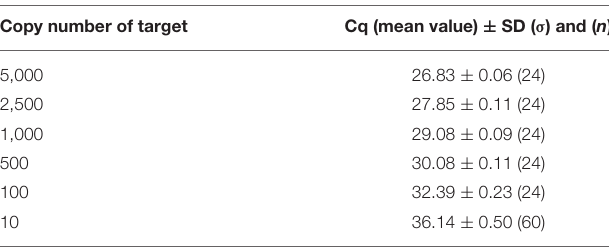
TABLE 7 | Cq values obtained on dilutions of plasmid material used for efficiency calculation and for LOD 95 % . Copy number of